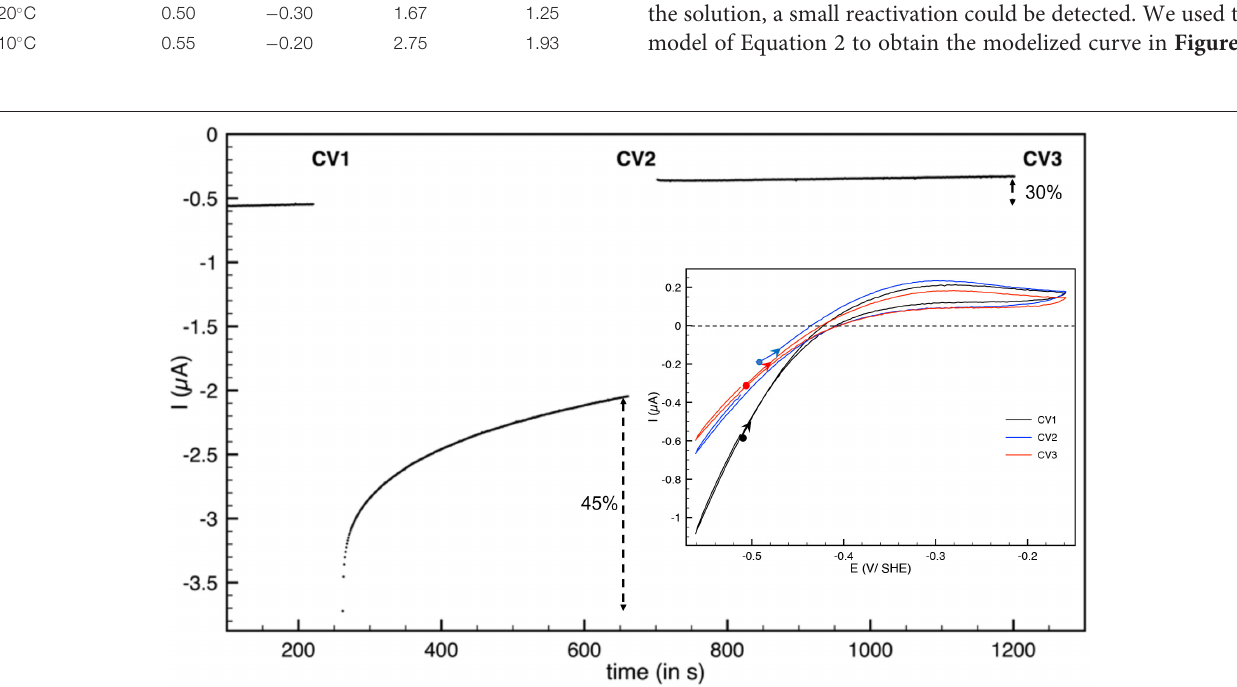
Frontiers in Chemistry |